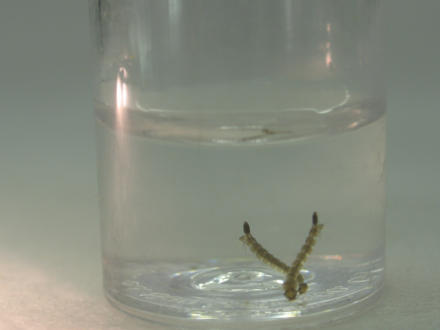
By accounting for competition between infected and uninfected mosquitoes, researchers discovered a link between parasitic virulence and the prevalence of infection in a population